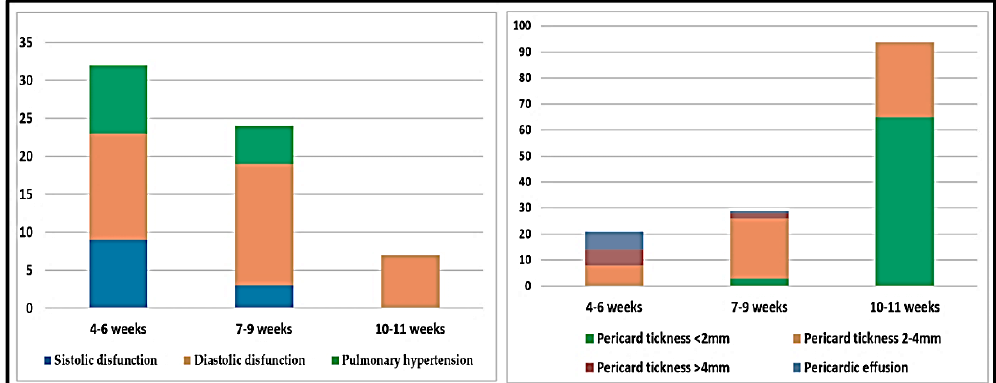
Figure 2. Time distribution of cardiac abnormalities assessed by TTE.